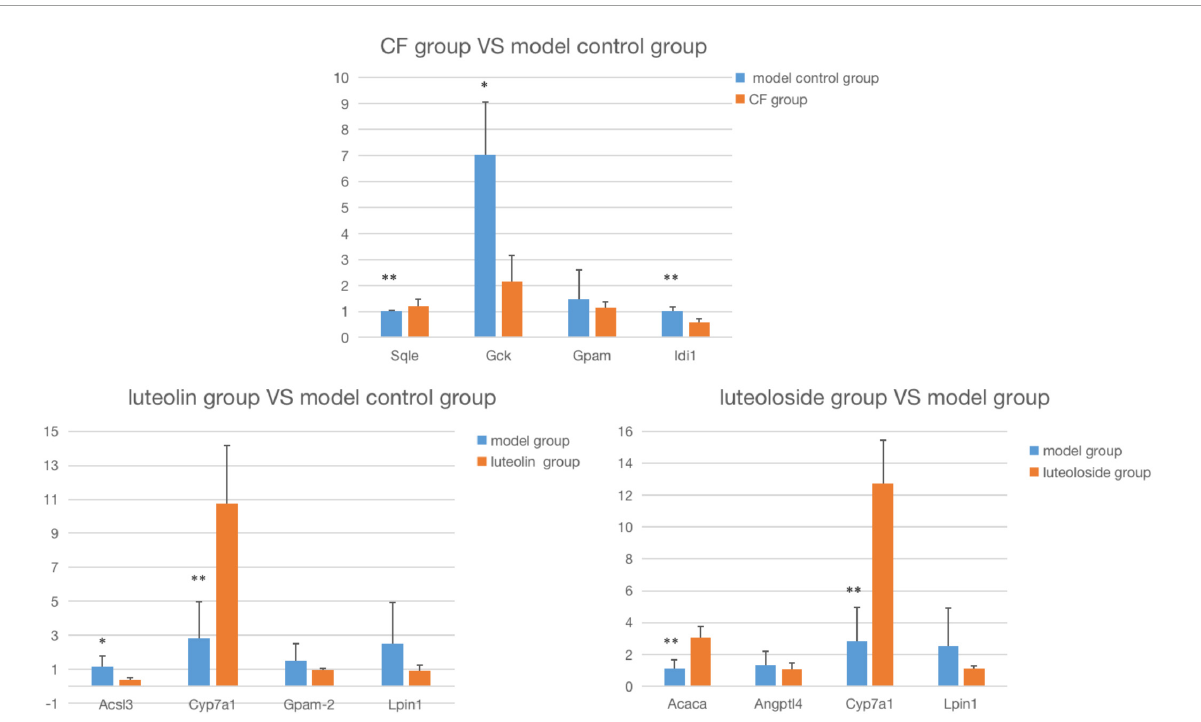
FIGURE6 The comparison between the RT-PCR and gene chip results. Compared with the model control group: * P < 0.05; ** P < 0.01.